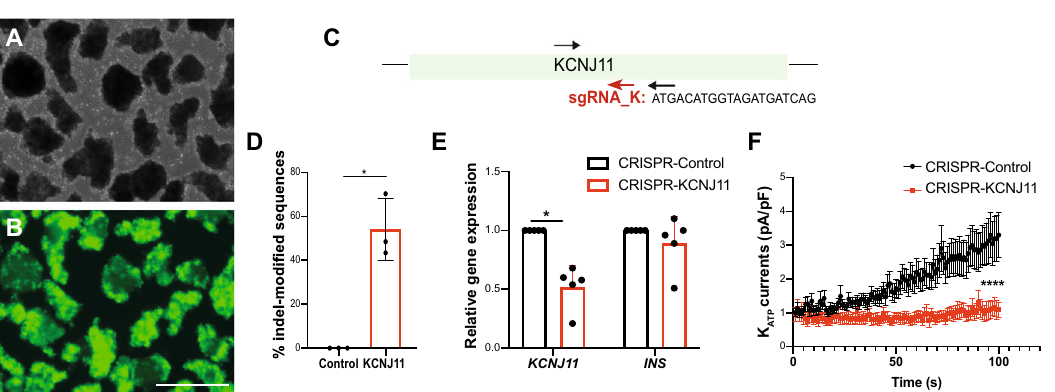
Fig. 2 CRISPR/Cas9 targeting of PDX1 in primary human islets leads to loss-of-function phenotypes. A Schematics of analyses performed to characterize the phenotype of CRISPR-PDX1 human pseudoislets. B Relative gene expression of known PDX1-targets in CRISPR-PDX1 GFP + cells relative to CRISPR-Control GFP + cells ( P = 0.0199 for PDX1 , P = 0.037 for INS , P = 0.0386 for GLUT2 , P = 0.013 for IAPP ). C Scheme of β -cell patch clamp. D – F β - cells show electrophysiological defects after CRISPR/Cas9 targeting of PDX1, including ( D ) impaired Na + ( P = 0.057) and ( E ) Ca 2 + currents ( P = 0.0012), and ( F ) reduced glucose-dependent β -cell exocytosis ( P < 0.0001). G Total insulin content in CRISPR-PDX1 GFP + cells relative to CRISPR-Control GFP + cells ( P = 0.036). H Secreted human insulin by CRISPR-Control versus CRISPR-PDX1 pseudoislets in vitro, following perifusion with media containing Glucose at 5.6, 6.7, and 16.7 mM + IBMX. I Area under the curve (AUC) of secreted human insulin by CRISPR-Control versus CRISPR-PDX1 pseudoislets at 16.7 mM ( P = 0.0387) and 16.7 mM Glucose + IBMX. J Serum human insulin levels in the blood of NSG mice one-month following transplantation of CRISPR-PDX1 versus CRISPR-Control pseudoislets, following intraperitoneal glucose tolerance tests (IPGTT) ( n = 3 independent human islets donors). K Area under the curve of the serum human insulin released by transplanted CRISPR-PDX1 versus CRISPR-Control pseudoislets, shown in ( J ) ( P = 0.049). K – S Immunostaining of grafts recovered one-month following transplantation with CRISPR-Control ( K – O ) versus CRISPR-PDX1 ( P – S ) pseudoislets; INS: gray, GFP: green, PDX1: red. Scale bars: 20 um. ( n = 3 independent donor repetitions). Data are presented as mean values ± SD for ( B – G , K ) and as mean ± SEM for ( I ) and ( J ). Two-tailed t tests were used to generate P -values. * P < 0.05, ** P < 0.01, **** P < 0.0001. Source data are provided as a Source Data fi le.